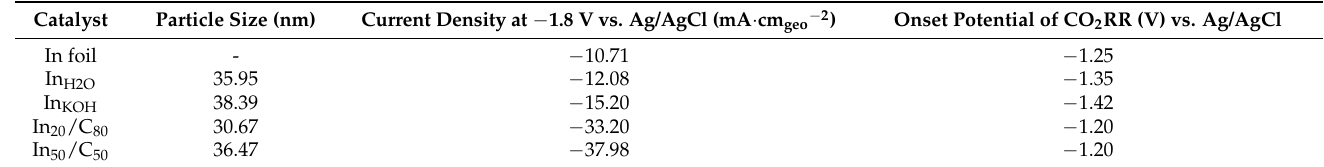
Figure 6. Cyclic voltammograms obtained in Ar (solid lines) and CO 2 (dashed lines) saturated solutions (KHCO 3 0.5 M + KCl 0.45 M) for: ( a ) In 20 /C 80 and ( b ) In 50 /C 50 NPs. Scan rate 50 mV · s − 1 . Table 1. Current densities (mA · cm − 2 ) of the different catalysts studied obtained in a CO 2 saturated